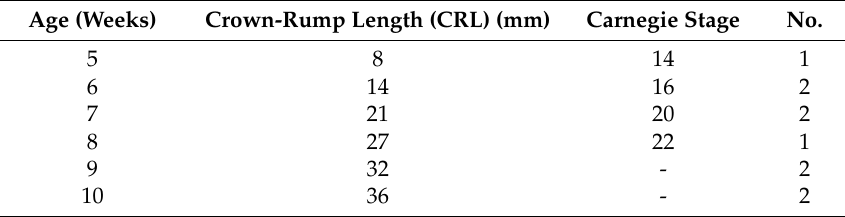
Table 1. The human conceptuses analyzed in this